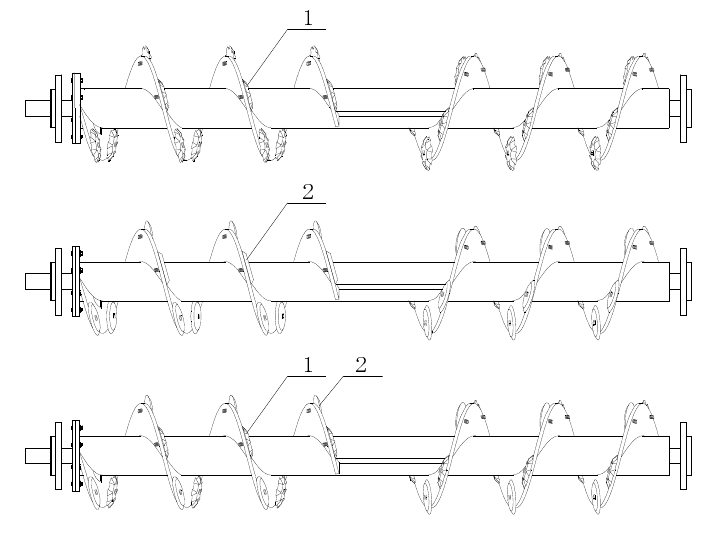
Figure 4. Blade installation form.